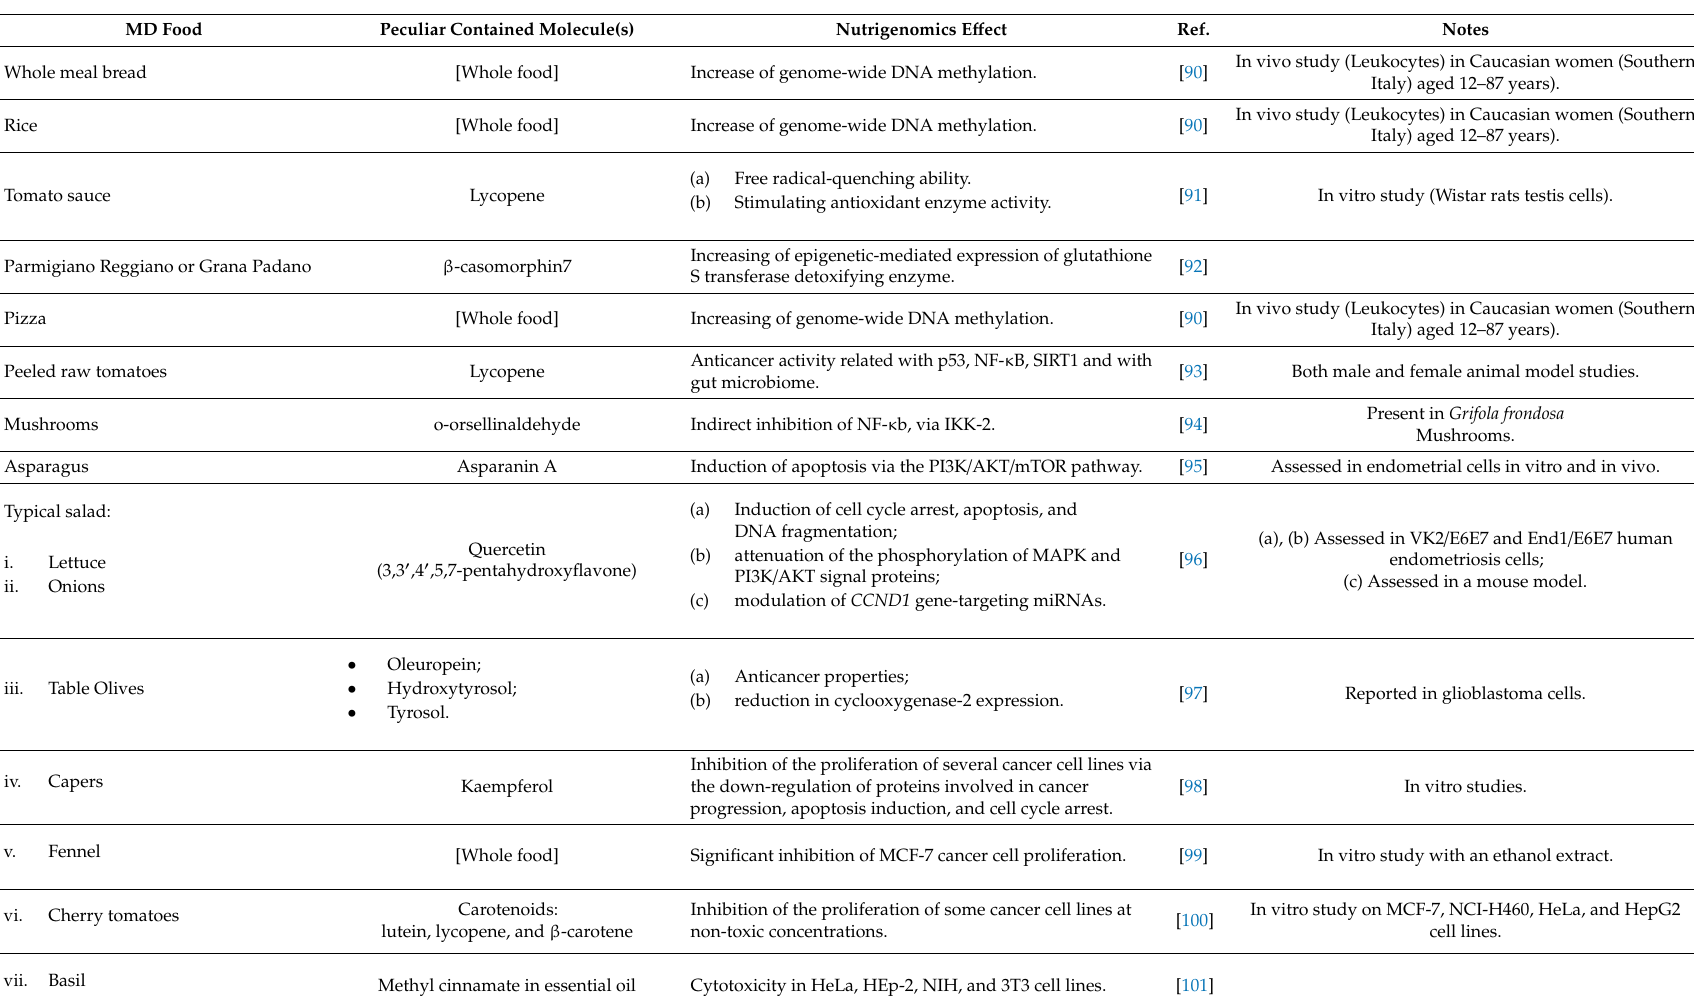
Table 1. Synoptic list of some other typical Mediterranean diet (MD) foods not described in the text with their respective nutrigenomic e ff